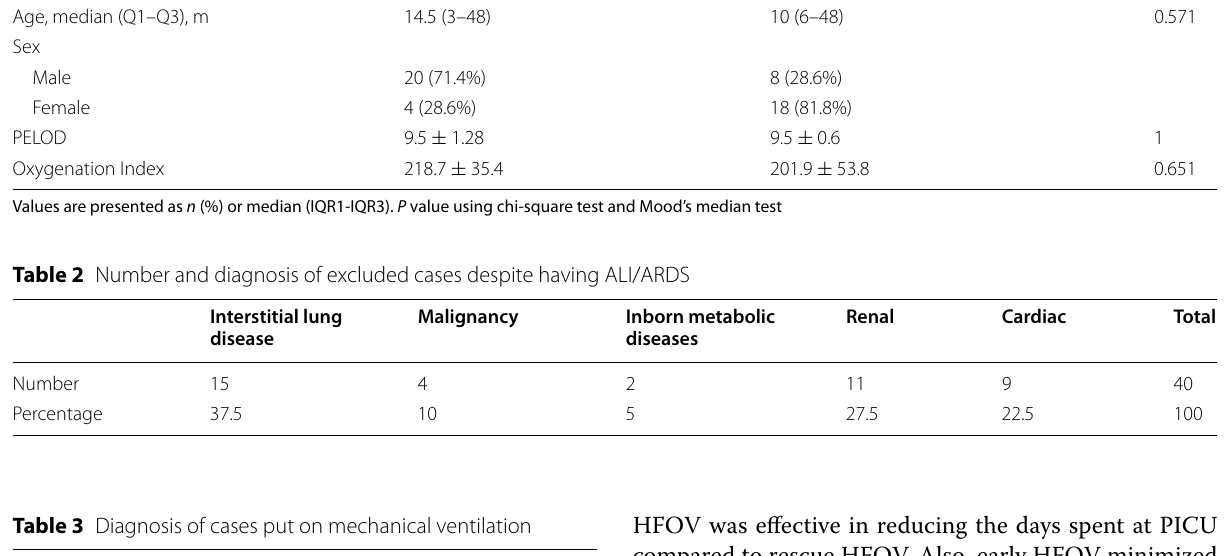
Table 3 Diagnosis of cases put on mechanical ventilation